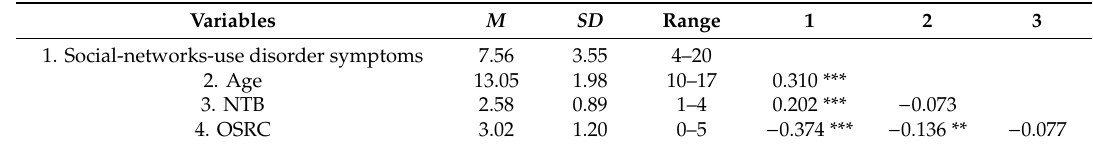
Table 1. Mean values, standard deviations, range, and bivariate correlations between the study’s variables.